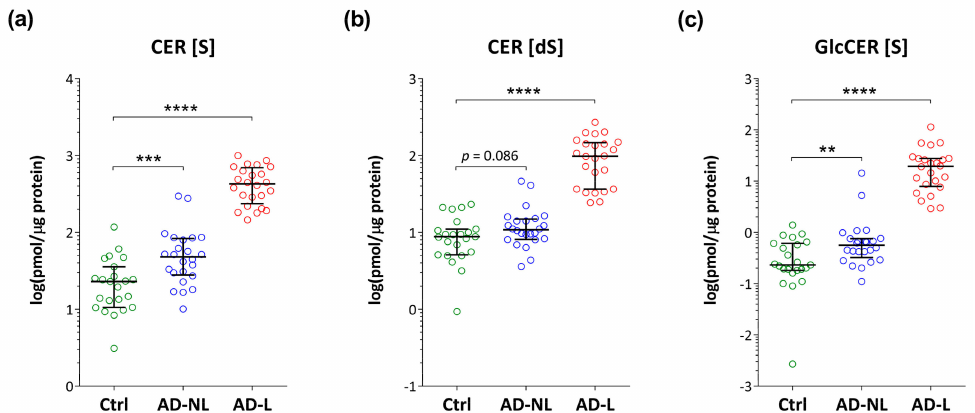
Figure 4. Levels of ( a ) sphingosine- and ( b ) sphinganine-based ceramides (respectively, CER (S) and CER (dS)) and ( c ) glucosylceramide (GlcCER (S)) in the skin of healthy controls (Ctrl) and non-lesional (AD-NL) and lesional (AD-L) skin in AD patients. Data are shown as median with interquartile ranges. **** p < 0.0001, *** p < 0.001, ** p <